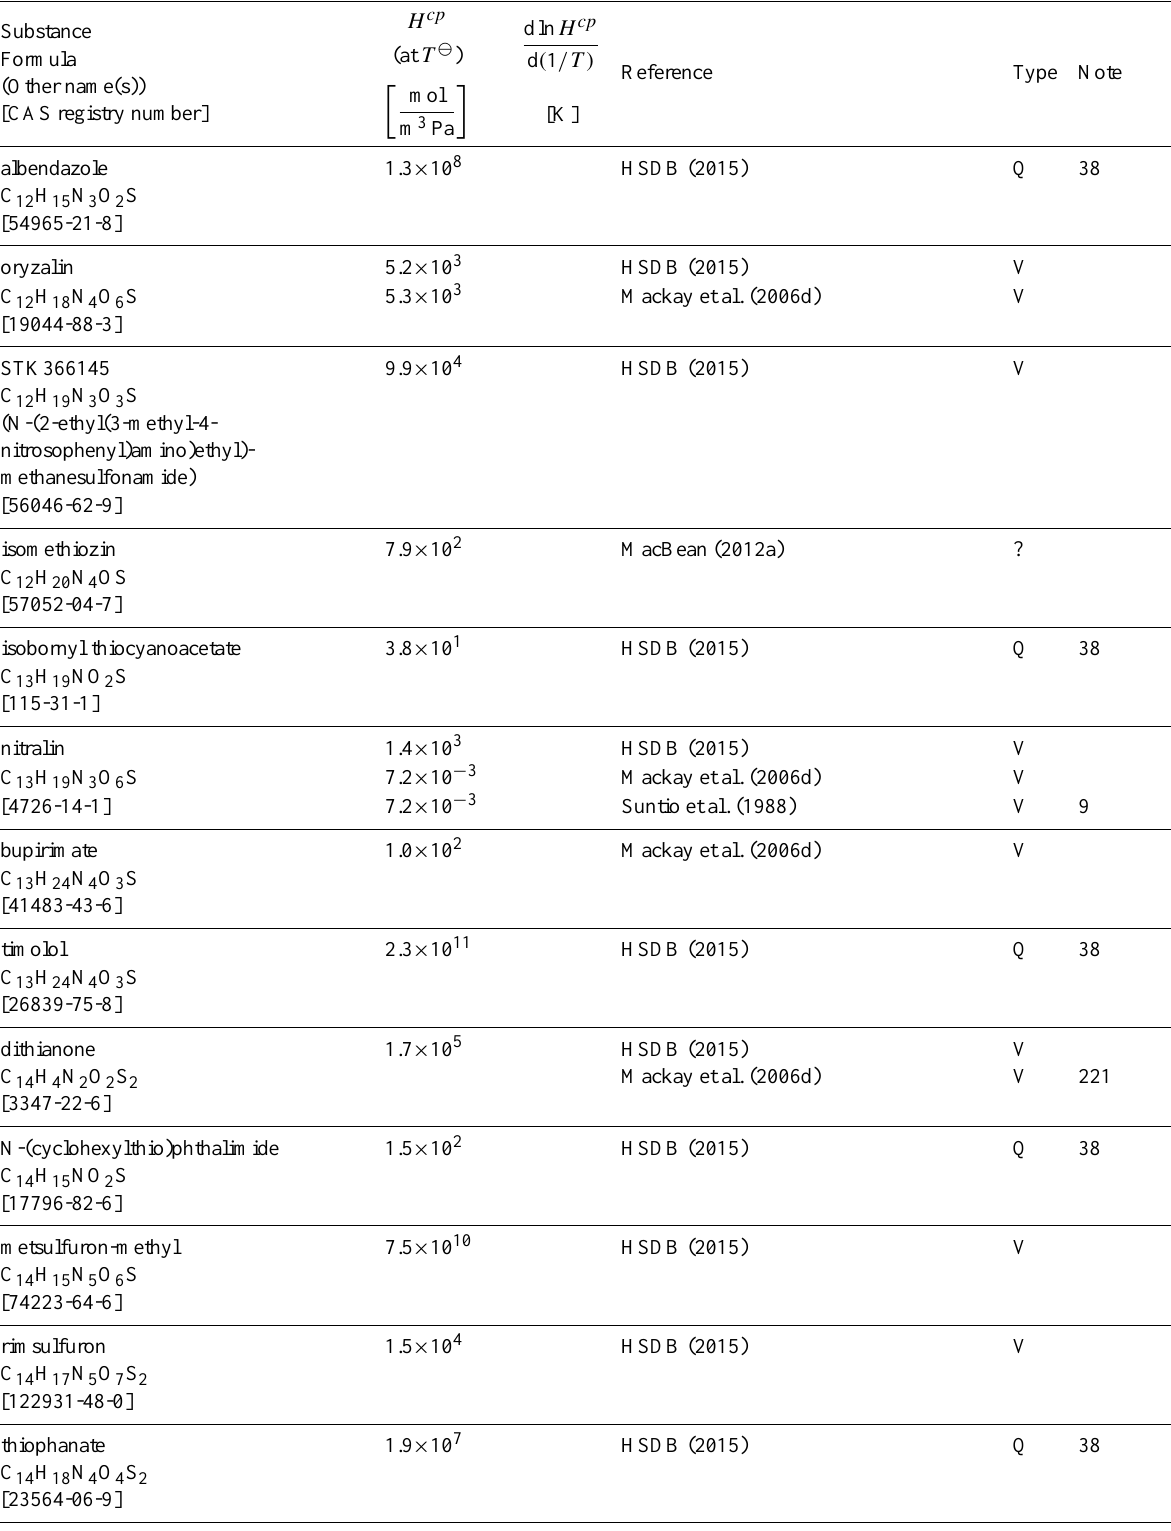
Table 6: Henry’s law constants for water as solvent